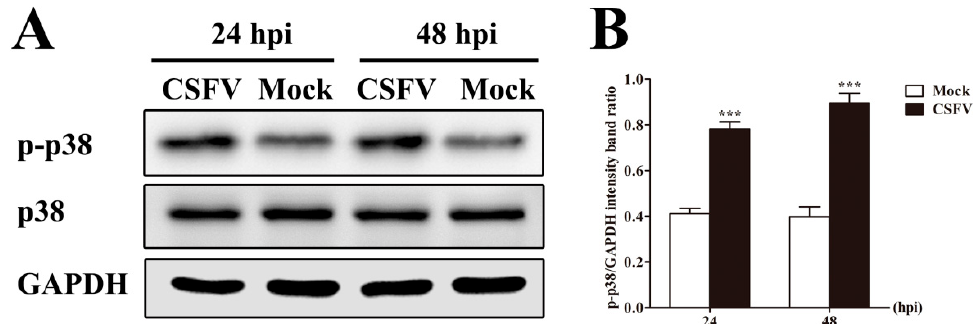
Figure 4. CSFV infection promotes p38 MAPK activation in PAMs. ( A ) Western blot analysis of p-p38 and